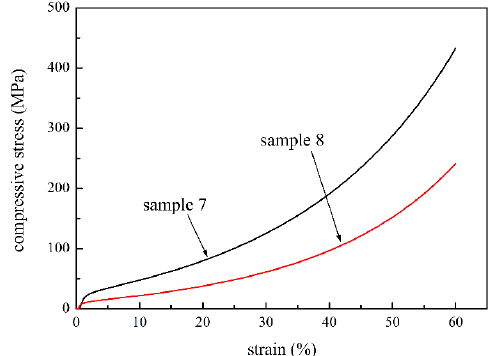
Figure 4. Compressive curves of the loosely sintered sample 7 and 8 with 6 wt.% and 0 wt.% fiber content, respectively.